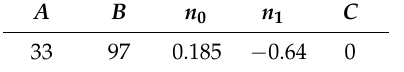
Table 2. Parameter values of 1070 aluminum for Equation (7).